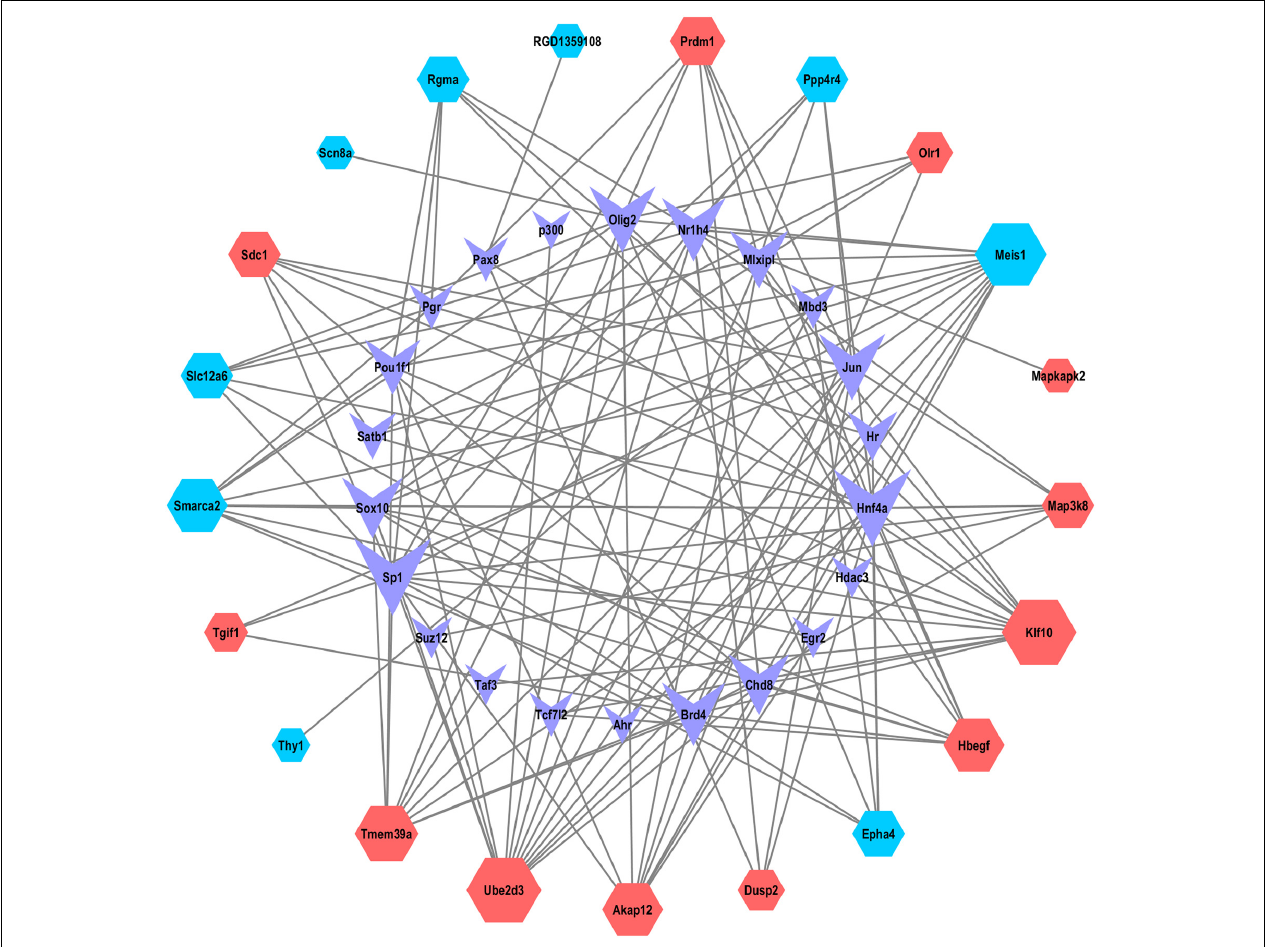
FIGURE 6 | The network of TFs and ceRNA-Pathway network related mRNAs. Nodes symbolize mRNAs indicated with diamond shapes, red represents upregulated genes and blue represent downregulated genes. The shape of purple V represents